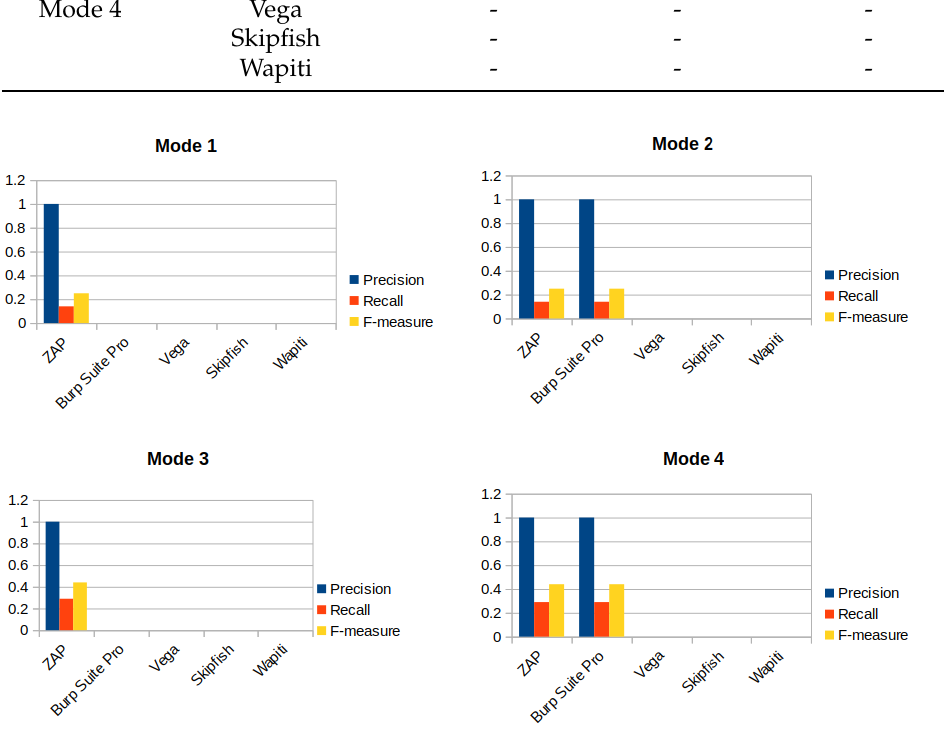
Figure 5. Obtained results of precision, recall, and F-measure in different